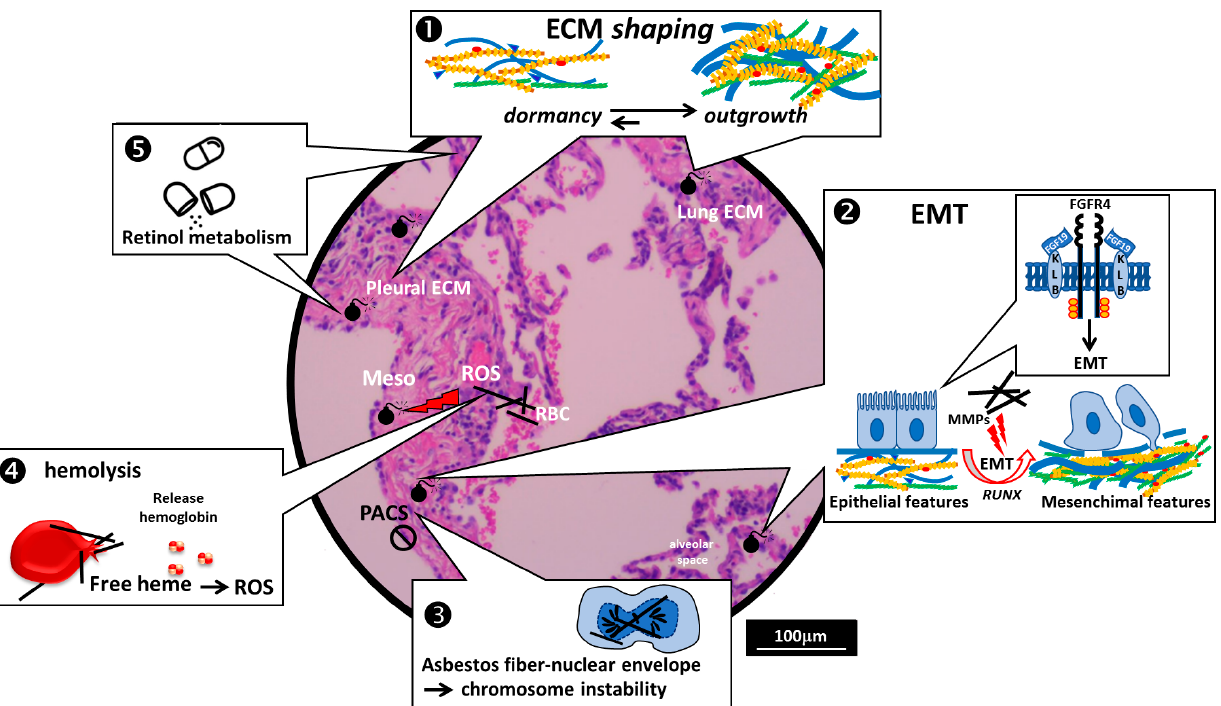
Figure 2. The importance of host genetics in asbestos-induced thoracic cancer susceptibility as deduced from VEA. Protective genetic asset (exclusive to asbestos survivors, indicated with the symbol ) preserving genomic stability: the possible role of PACS proteins. Susceptibility assets (exclusive to individuals who developed asbestos-related thoracic cancers, indicated with the symbol ): ECM shaping of the lung/pleural tumor microenvironment in determining dormancy or outgrowth: abnormal ECM dynamics lead to deregulated cell proliferation and invasion, resulting in pathological processes including cancer. EMT as the initial step in tumorigenesis; Asbestos fibers and the nuclear envelope. Dysregulation of the nuclear envelope reassembly and susceptibility of developing MPM: a confirmation of the role of the well-documented close interaction between asbestos and the nuclear envelope of mesothelial cells in the induction of chromosome rearrangements seen in MPM; The emerging role of free heme in MPM pathogenesis: defective scavenging of free heme released by asbestos-fibers-induced hemolysis could contribute to asbestos-induced oxidative stress; The retinoid (Vitamin A) risk: dysregulated retinoid metabolism in asbestos-exposed individuals could contribute to asbestos-induced thoracic cancer pathogenesis. The histological image is a representative microphotograph relative to a Hematoxylin-and-Eosin-stained section of non-tumor lung which includes both pleural and lung tissue with the sole purpose of acting as a background for the schematic representation. Meso = Mesothelium, Red Blood Cells = RBC, AF = Asbestos Fibers, ROS = Reactive Oxygen Species, ECM = Extracellular Matrix, HS-GAGs = Heparan Sulphate Glycosaminoglycans, HSPGs = Heparan Sulphate ProteoGlycans.